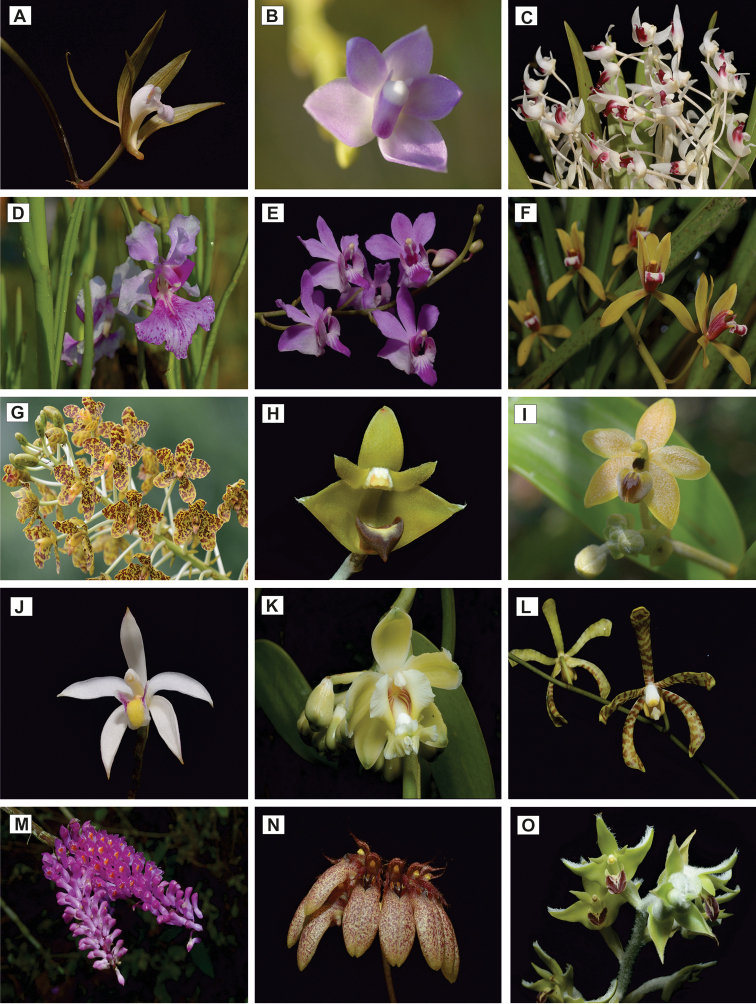
A selection of Orchidaceae species from Setiu Wetlands. AAnia
penangianaBThrixspermum
amplexicauleCPinalia
atrovinosaDPapilionanthe
hookerianaEPhalaenopsis
pulcherrimaFCymbidium
finlaysonianumGGrammatophyllum
speciosumHStrongyleria
panneaICallostylis
pulchellaJBromheadia
finlaysonianaKVanilla
griffithiiLArachnis
flos-aerisMDendrobium
secundumNBulbophyllum
trigonopusODendrolirium
lasiopetalum.